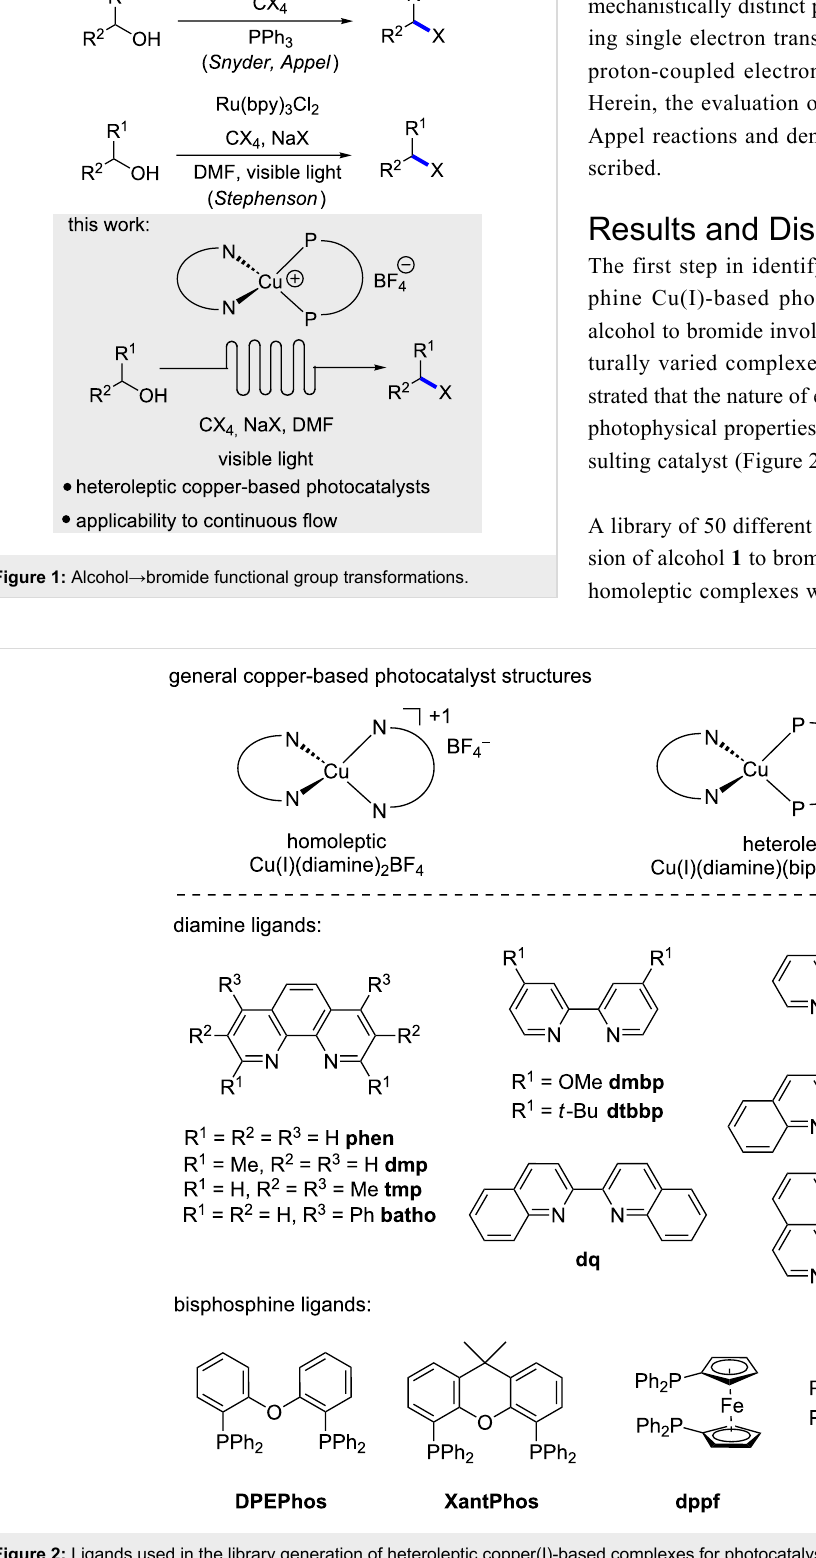
Figure 2: Ligands used in the library generation of heteroleptic copper(I)-based complexes for photocatalysis.